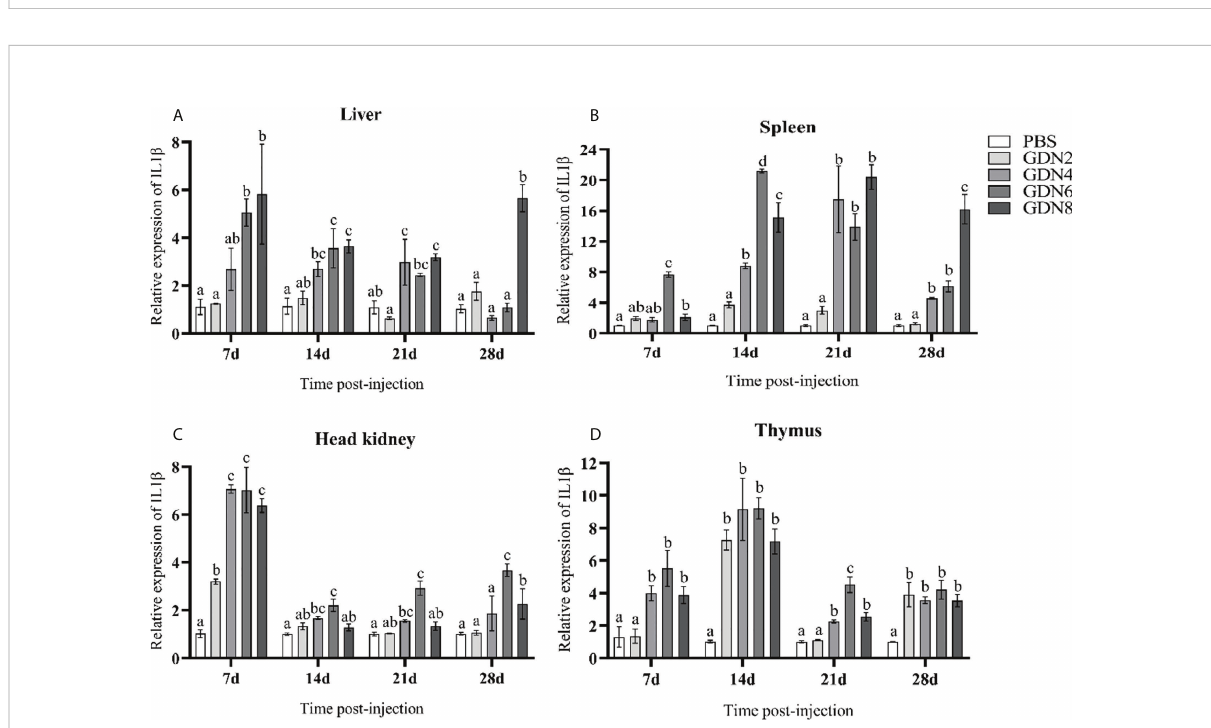
FIGURE 6 Expression levels of the TNF- a gene in the four tissues of pearl gentian grouper ( A , liver; B , spleen; C , head kidney; D , thymus) by qRT-PCR post-injection. The mRNA levels of the TNF- a gene were normalized to those of b -actin, and the relative expression levels were calculated. Signi fi cant differences ( p < 0.05) are marked by different letters (a –